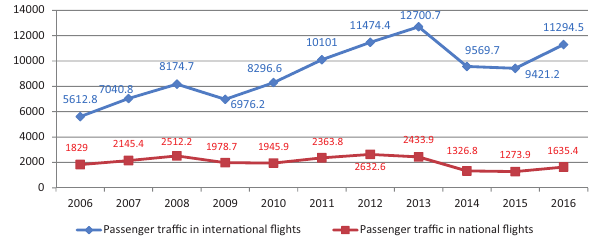
Figure 7. Passenger traffic in international and